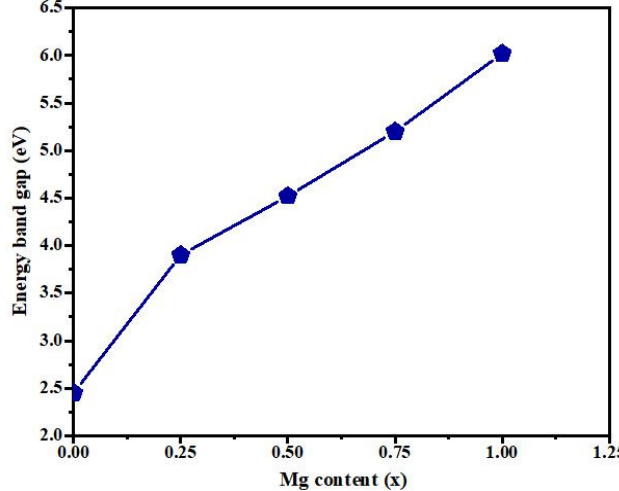
Figure 8. Variation of energy band gap with the increase in Mg content.